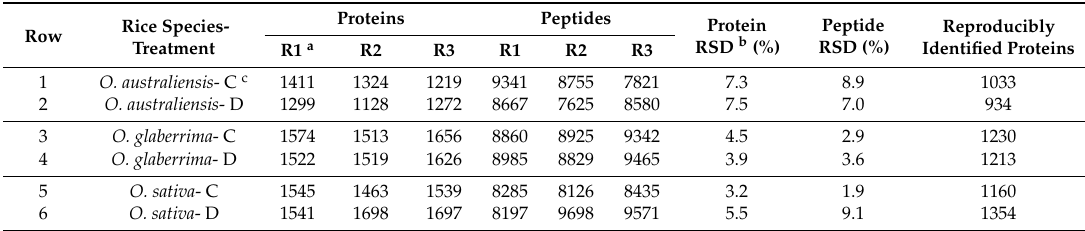
Table 2. Summary of protein identification data of leaf samples for three species of